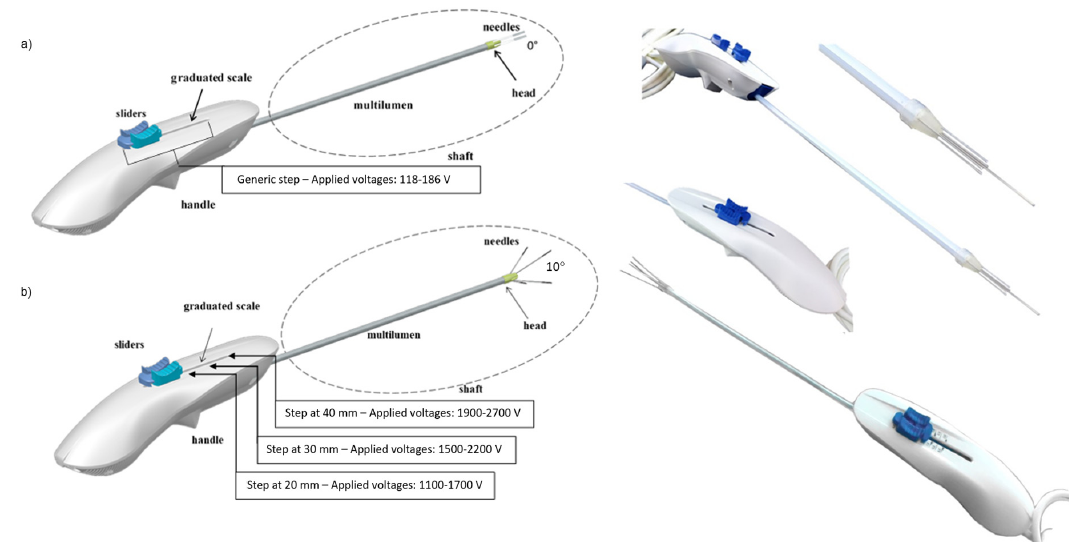
Figure 1. Rendering representation and real realization of deployable expandable electrodes with ( a ) zero and ( b ) non-zero divergence (10° of divergence between peripheral needles and electrode shaft axis). In the deployable expandable electrode without divergence, the applied voltage is 118 V between each peripheral needle, and the central one, and 186 V between two consecutive peripheral needles. In the deployable expandable electrode with 10° of divergence, the applied voltage depends on the needle deployment: at 20 mm the applied voltages are 1100 V and 1700 V (for side and diagonal d of the electrode, respectively); at 30 mm, the applied voltages are 1500 V and 2200 V; at 40 mm the applied voltages are 1900 V and 2700 V. The insulation layer of the electrodes is fixed. The voltages are defined in order to obtain an electric field ≥ 1500 V/cm for irreversible electroporation .